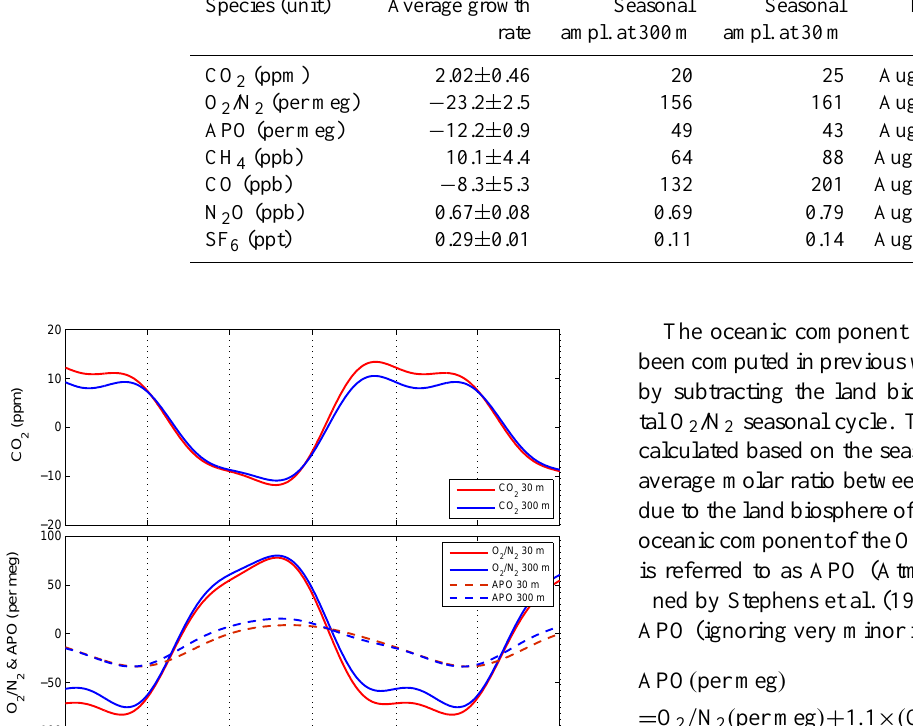
Table 4. Trends and seasonal amplitudes for the species measured in-situ at Bialystok. Species (unit) Average growth Seasonal